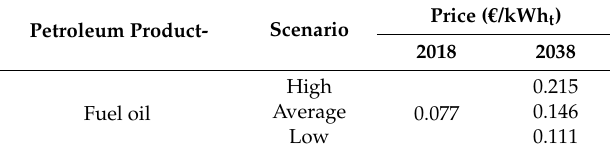
Table 12. Diesel oil price forecast, 2018–2038.